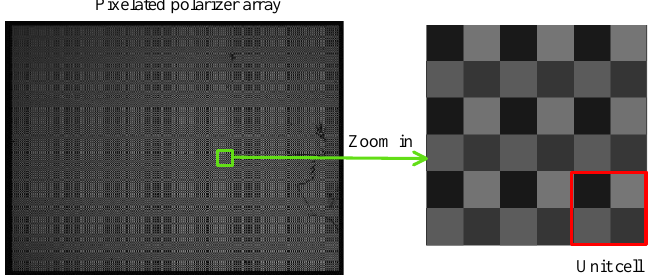
Figure 2. Intensity response of the Charge Coupled Device (CCD) pixels under linearly polarized